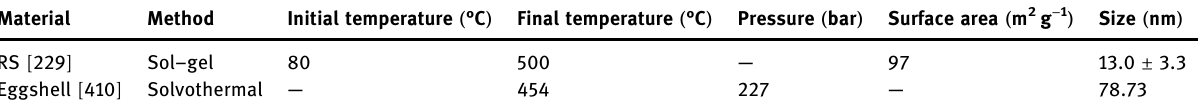
Table 7: Di ff erent chemical methods for the synthesis of TiO 2 NPs and their corresponding properties Material